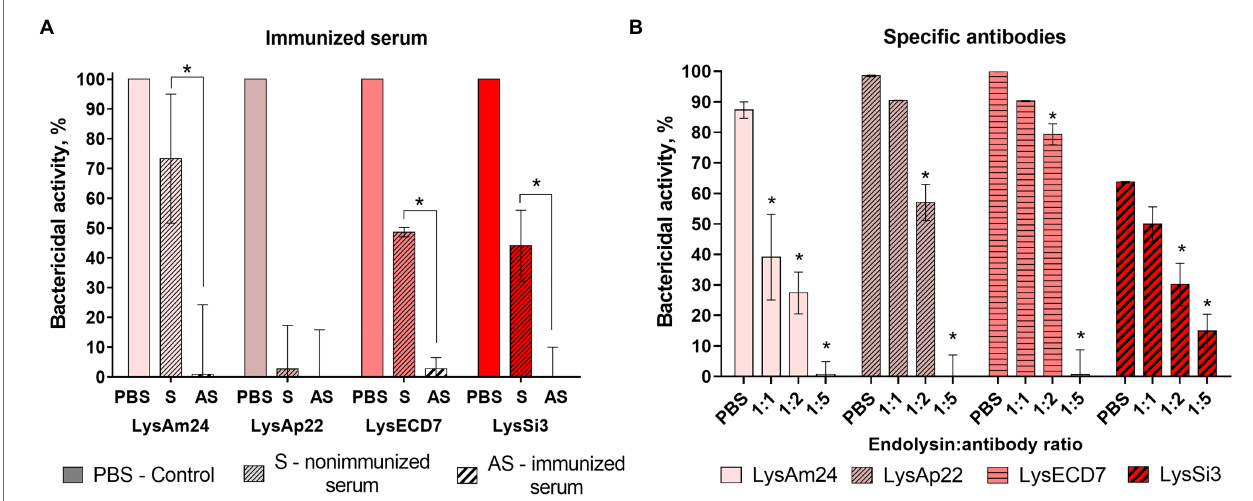
FIGURE 3 | The neutralization effects of immunized serum (A) and specific antibodies (B) toward four endolysins. LysAm24, LysECD7, LysAp22, and LysSi3 were preincubated with endolysin-immunized rabbit serum, nonimmunized serum, PBS solution, or affinity-purified antibodies for 10 min at 37 ° C. Each mixture was then added to the growing culture of A. baumannii Ts 50-16, and CFU count was estimated after 30-min incubation. Data are shown as mean ± SD (one-way ANOVA). Asterisk (*) indicates significant difference in activity compared to nonimmunized serum (A) or control in PBS (B ; p <